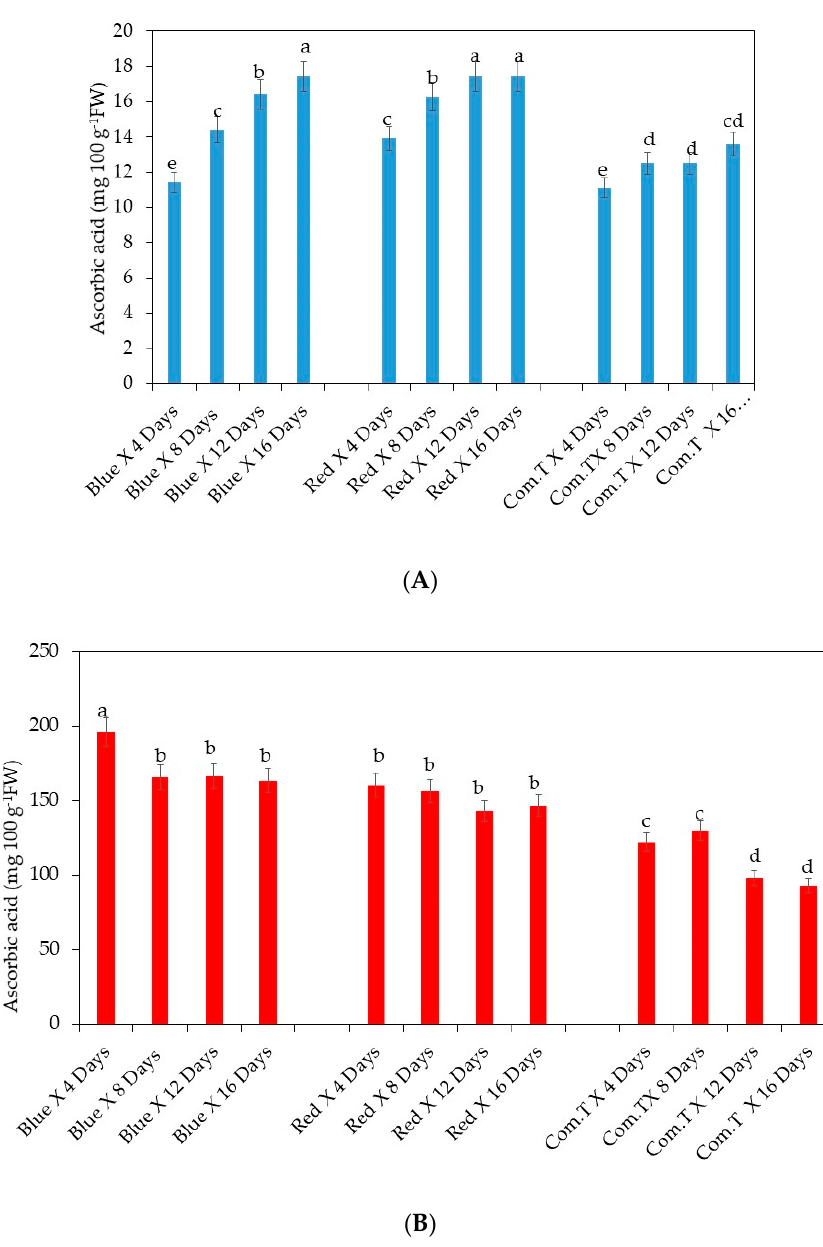
Figure 10. ( A ) Influence of LED lights on ascorbic acid content in the mesocarp of avocado cultivar Fuerte. ( B ) Influence of LED lights on ascorbic acid content in the mesocarp of avocado cultivar Hass. Mean ± standard deviation values for each bar were calculated based on five fruits. Number of replicates per treatment n = 5. Mean values of bars marked by different letters were significantly different at p < 0.05, according to Fisher’s protected LSD test. Blue, blue LED light; Red, red LED light; Com.T, commercial treatment.